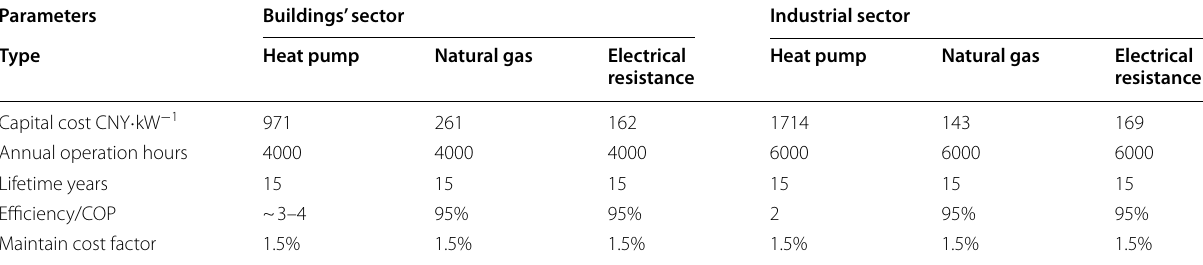
Note: The typical lifetime years, maintain cost factor, COP value are determined by some references [4, 59] and our investigation, while capital cost is based on our investigation on the market available products on average, while 20 kW heater for building sector with and 350 kW steam boiler for industrial sector. The calculation model does not consider financing or inflation, nor the degradation of collector efficiency or any residual value of the asset